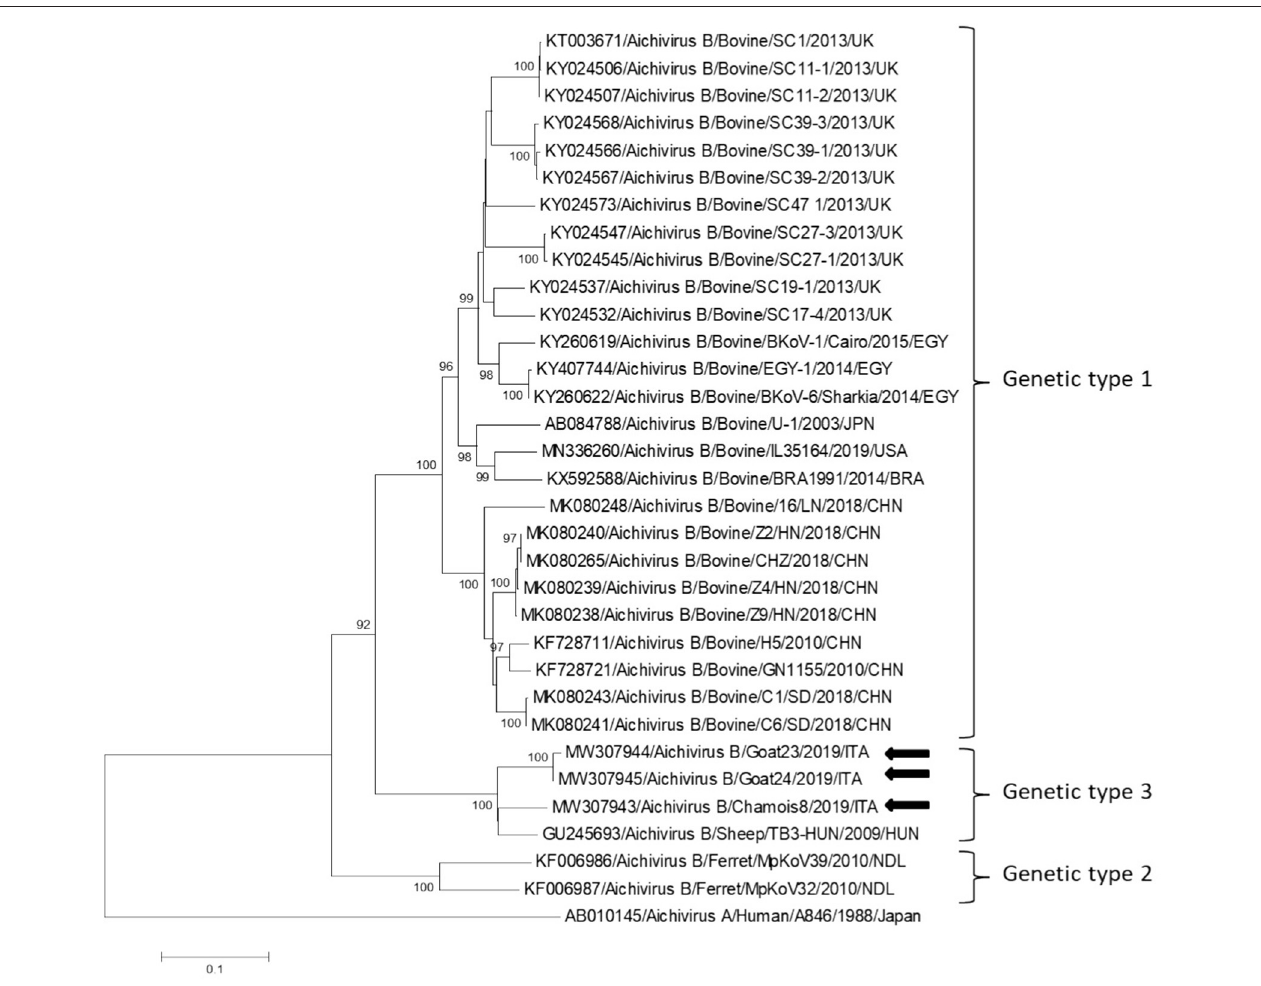
FIGURE 3 | Phylogenetic tree based on the nt sequence of the VP1 encoding gene constructed with a selection of strains representative of the species Aichivirus B. Tree was generated using the neighbor-joining method with kimura 2-parameter model and supplying statistical support with bootstrapping of 1,000 replicates. The arrows indicate the KoV strains detected in this study. Human aichivirus A strain A8461 (GenBank accession no. AB010145) was used as